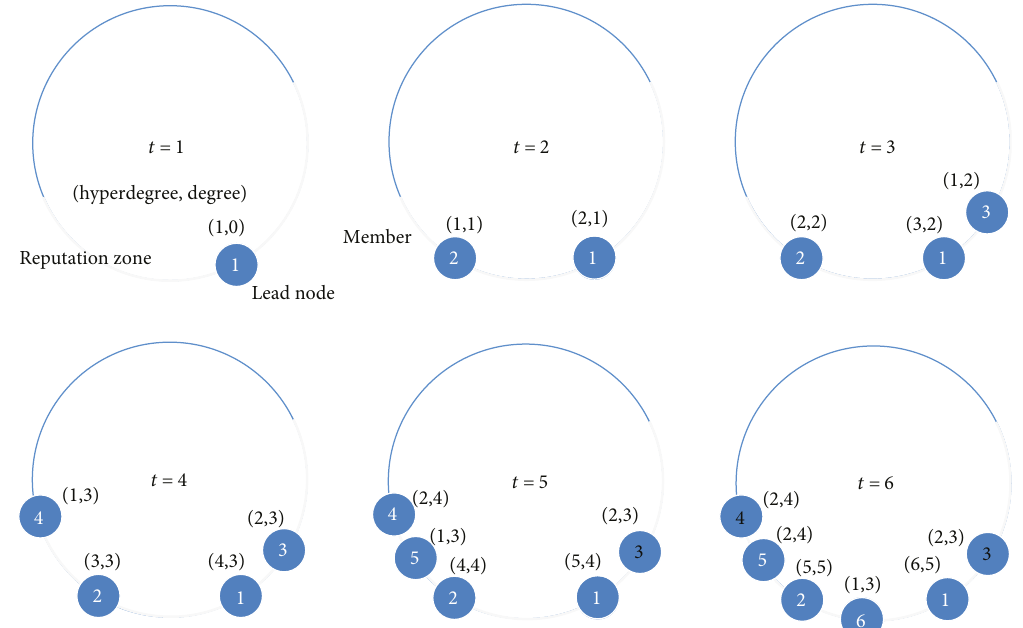
Figure 1: An illustration of an evolutionary research team. At each time, a new player joins the research team, and the group of the players with white numbers forms a hyperedge. It illustrates a usual scene. New coming player 6 wants to complete a work and write it as a paper. Suppose completing the paper needs four players. Then player 6 would ask leader 1 for help, and the leader would suggest team members 2 and 3, who have the most similar interest to player 6, to